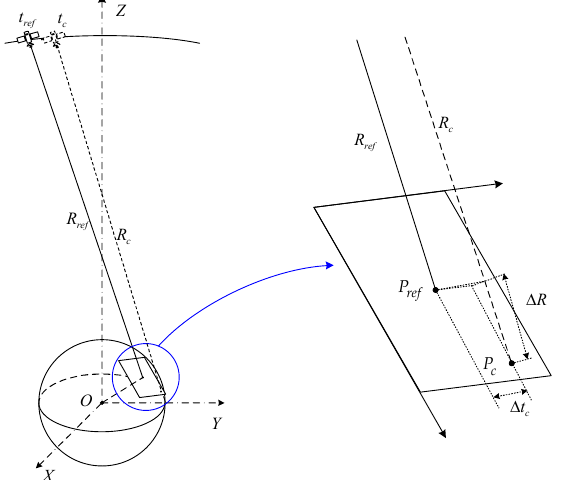
Figure 2. Observation geometry between strip-map GEO SAR imaging and a target zone as the GEO SAR platform moves along its orbit. The target zone area enclosed by the blue circle in the diagram on the left side is enlarged in the diagram on the right side. At t ref and t c , the beam center points to targets P ref and P c , respectively, where P ref is the reference target, which is also the center of the target zone. At t ref , the slant range between the beam center and P ref is R ref . At t c , the slant range between the beam center and P c is R c